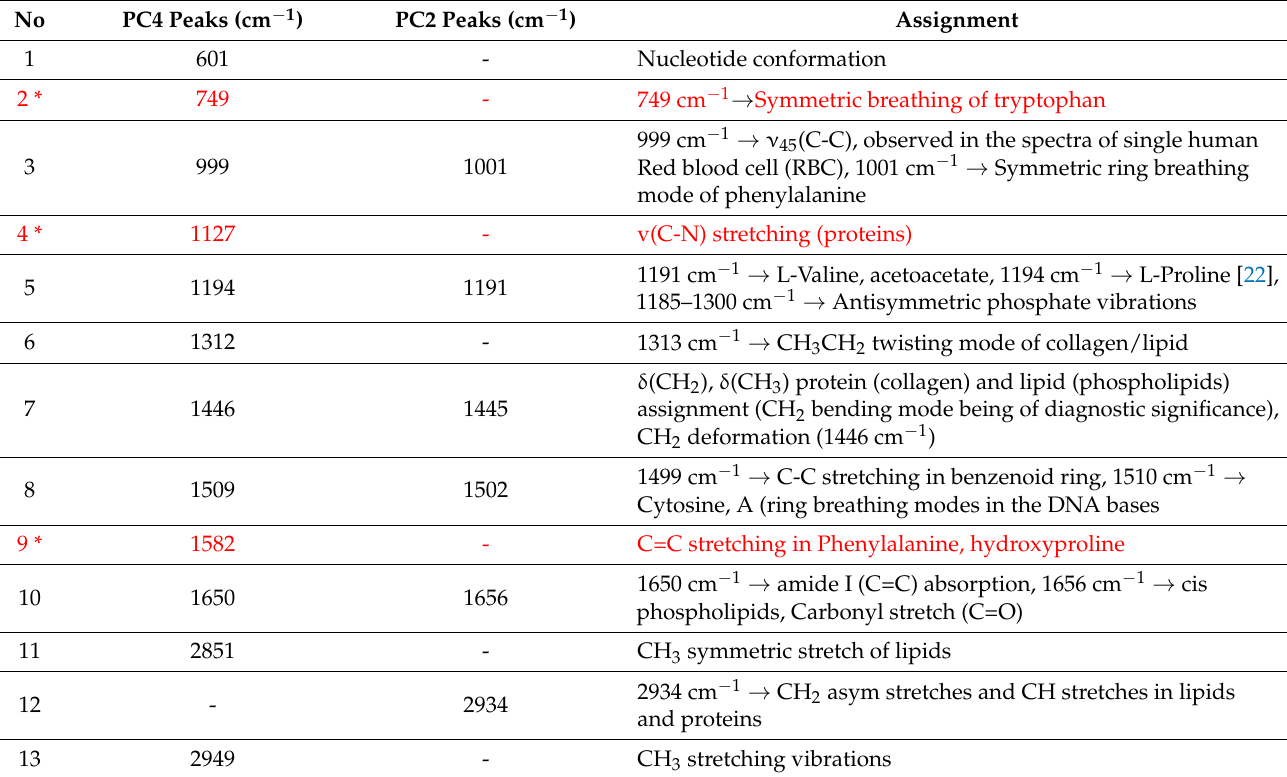
Table 3. Major Raman peaks found in PCA between BR1 and BR3, 4. In red color and with an asterisk superscript the temperature dependent Raman peaks are presented.